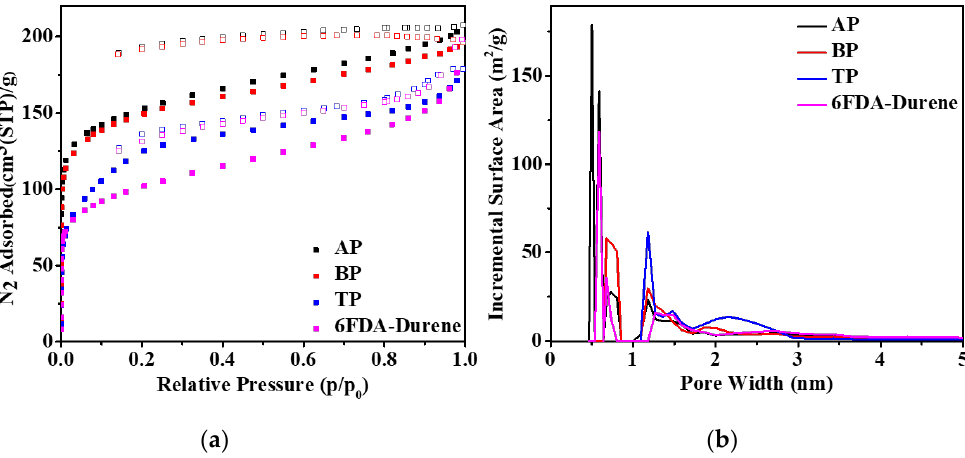
Figure 2. ( a ) N 2 adsorption (solid) and desorption (hollow) isotherms of AP, BP, TP, and 6FDA-Durene at 77 K; and ( b ) pore size distribution calculated by NLDFT.